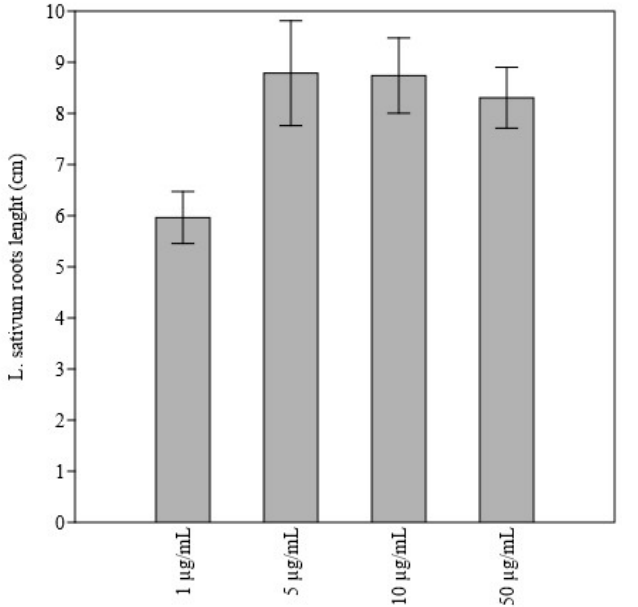
Figure 5. Bar-chart showing L. sativum roots length (cm) after application of 1 µg/mL in comparison to 5 µg/mL, 10 µg/mL, and 50 µg/mL doses of sabinene.